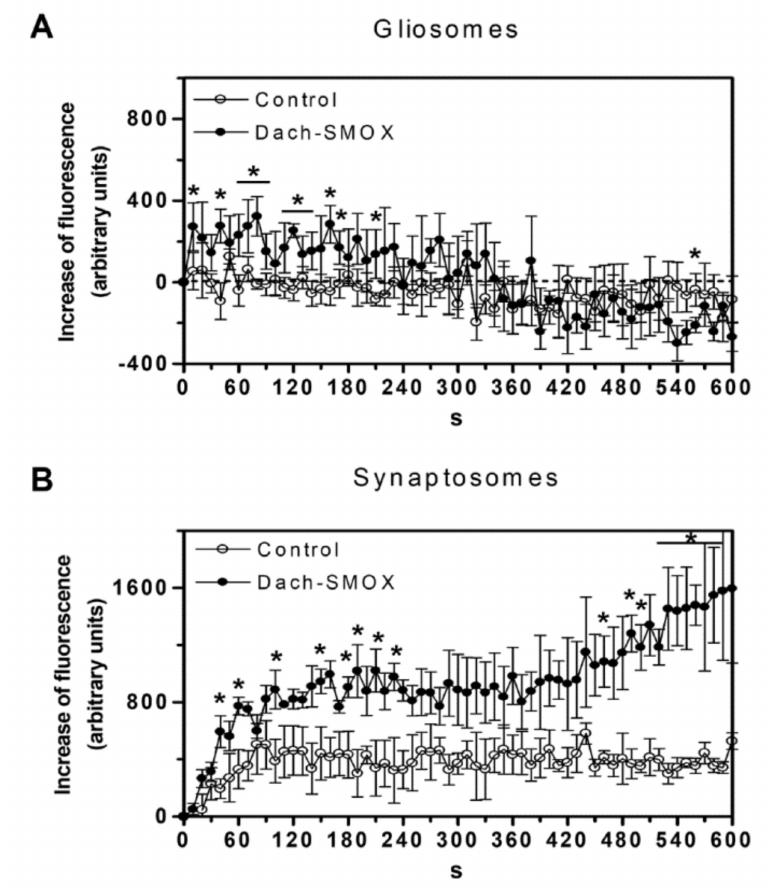
Figure 3. AMPA receptor activation-evoked [Ca 2+ ] i increase in Dach-SMOX cerebrocortical gliosomes and synaptosomes. CG-loaded particles (gliosomes or synaptosomes) from control (